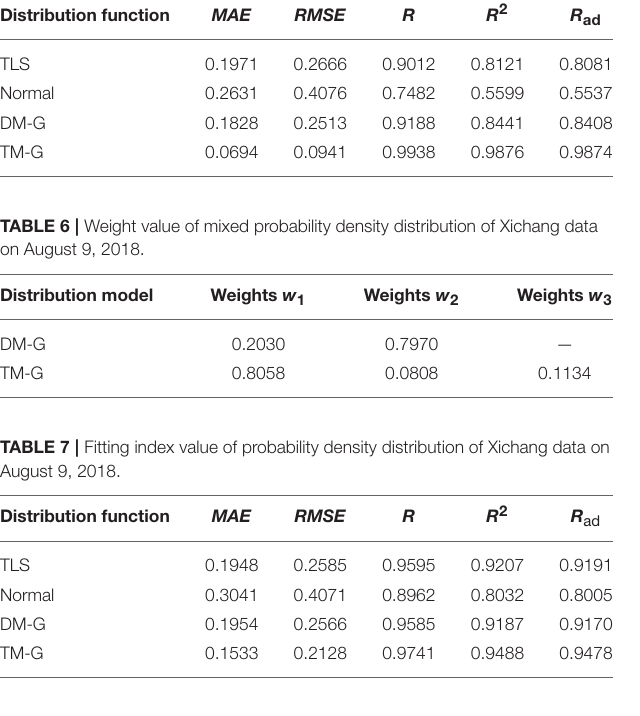
TABLE 5 | Fitting index value of probability density distribution of Xichang data on July 20, 2018. Distribution function